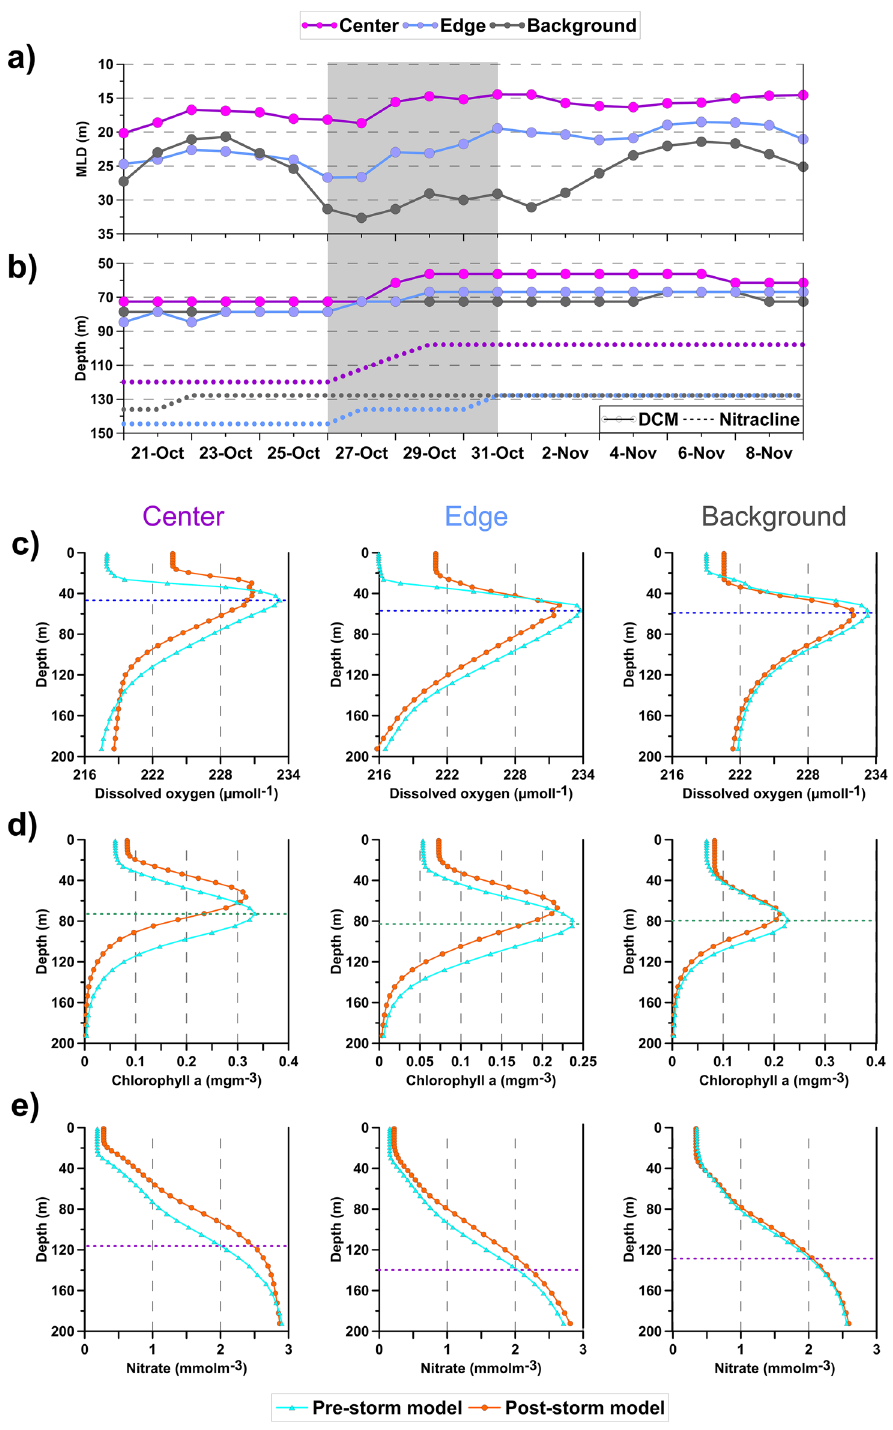
Figure 6. Time series of the MLD ( a ), DCM and nitracline ( b ) covering the Pre-storm, In-storm (grey shaded area) and Post-storm time periods derived from biogeochemical CM model. Mean profiles of the Dissolved Oxygen ( c ), Chlorophyll-a ( d ) and Nitrate concentration ( e ) derived from the biogeochemical CM model for the Pre-storm and Post-storm conditions, in the Center (first column), Edge (central column) and Background (right column)